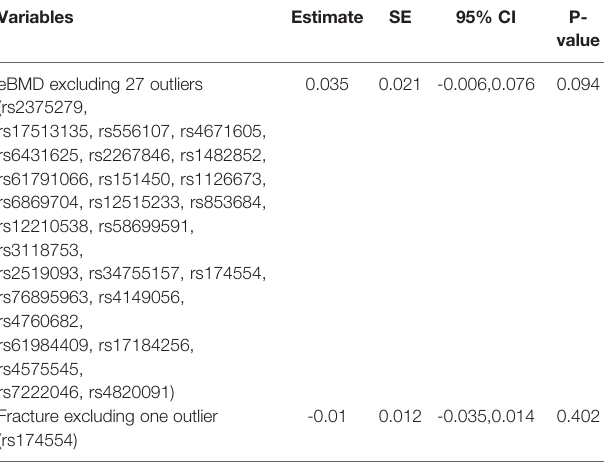
TABLE 2 | Mendelian randomization estimates between bilirubin levels and osteopross after excluding outliers detected by PRESSO. Variables Estimate SE 95% CI P-